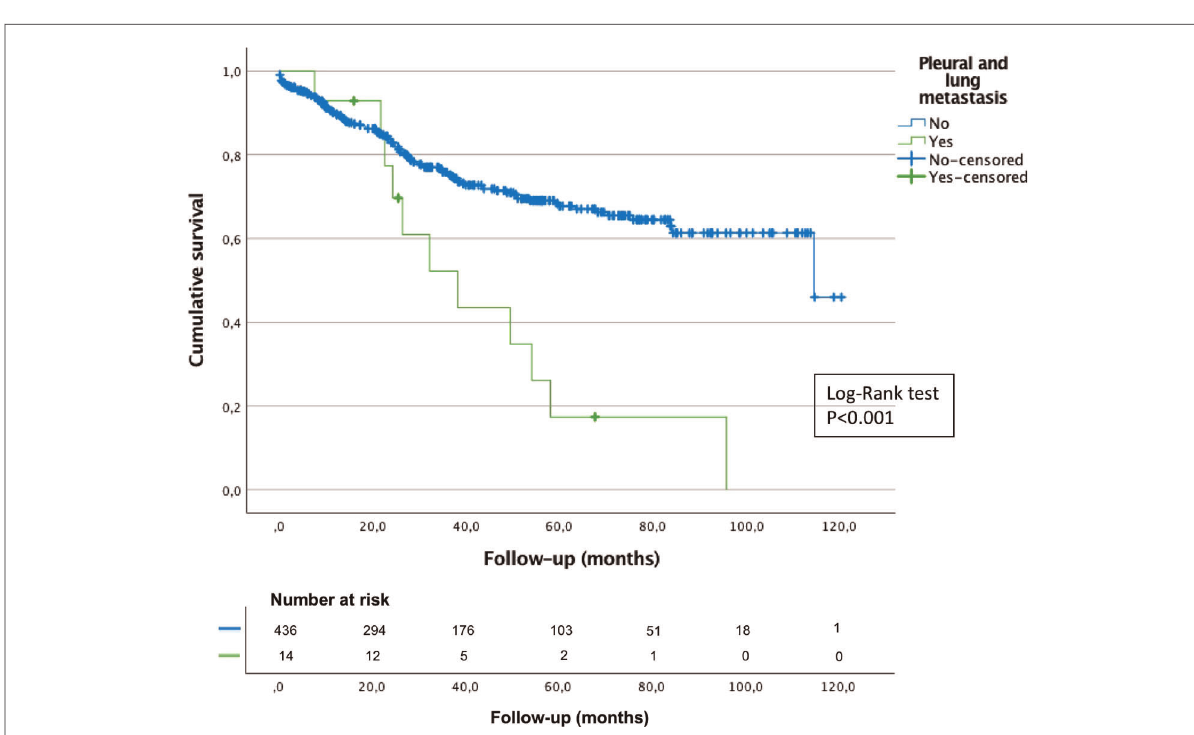
FIGURE 3 Overall survival of gastric cancer patients treated with curative intent who developed or not pleuro-pulmonary lung metastases, Kaplan-Meier curve with Log-Rank